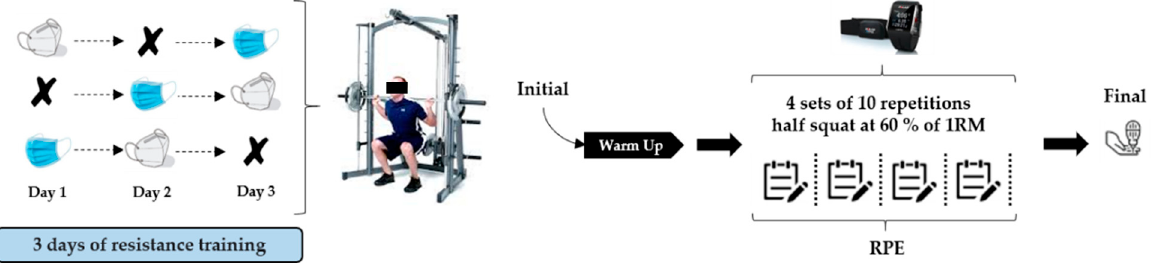
Figure 1. Graphical representation of the study design.